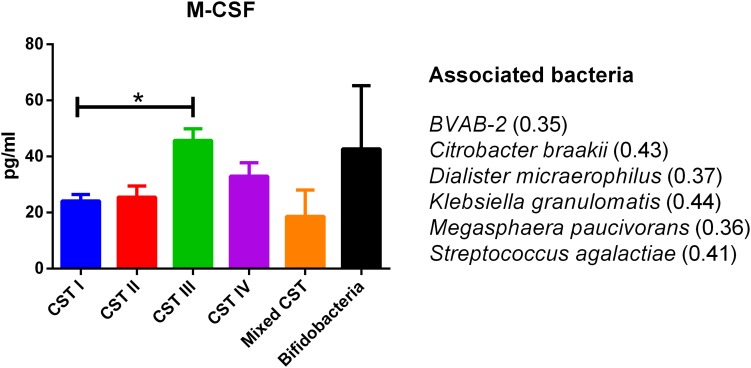
Generic marker of dysbiosis. According to the Pearson correlation score, M-CSF significantly (FDR p-value <0.001) correlated with several microorganisms. The association was calculated by means of the observation_metadata_correlation.py script on the rarefied otu_table.biom (5,000 reads/sample). The amount of M-CSF also varied based on the community state type (CST). The comparisons were performed by means of a Kruskal–Wallis one-way analysis of variance. When a significant p-value was observed (p < 0.05), a multiple comparison test was used to determine which groups were different. The data are shown as the mean value ±standard error of the mean (SEM). Pearson scores for every bacterial species are shown in brackets. FDR, false discovery rate; M-CSF, macrophage colony-stimulating factor. ∗p < 0.05.